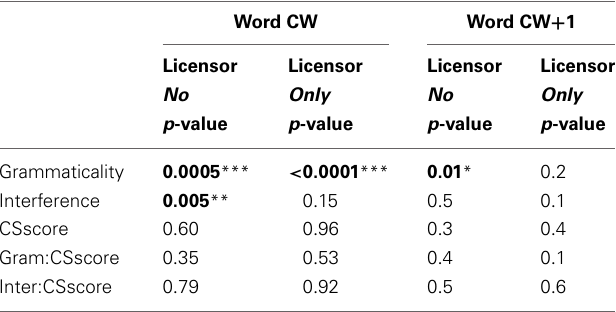
Table 6 | NPI licensing RTs: fixed effects from the linear mixed effect models, separated for two different